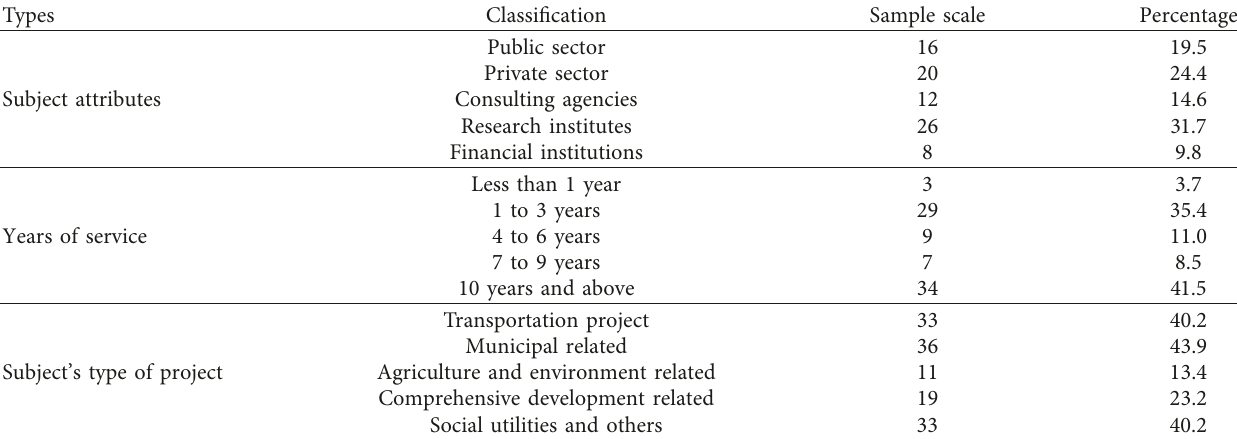
Table 2: Sample background